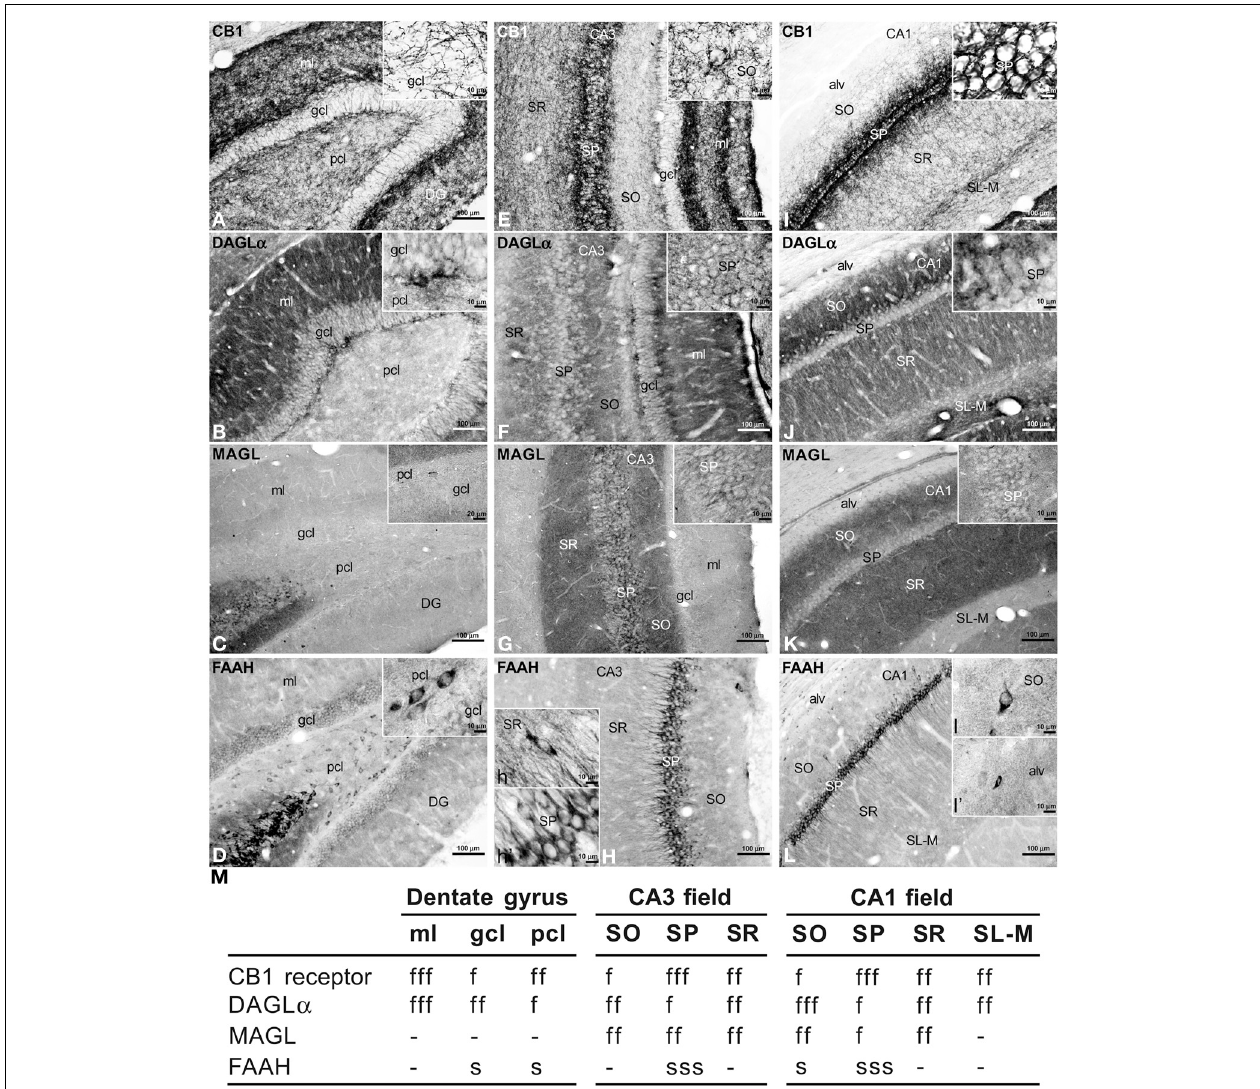
FIGURE 2 | Immunohistochemical expression of CB 1 (A,E,I), DAGL α (B,F,J), MAGL (C,G,K), FAAH (D,H,L) in the rat dentate gyrus (A–D), CA3 (E–H), and CA1 (I–L). Results are summarized in a rating gray-scale of the immunoreactivity in somata and fibers of each layer and stratum of the hippocampus (M) . Three labeling intensities are represented from “f/s” meaning “low” fiber and/or somata (above the background density) to